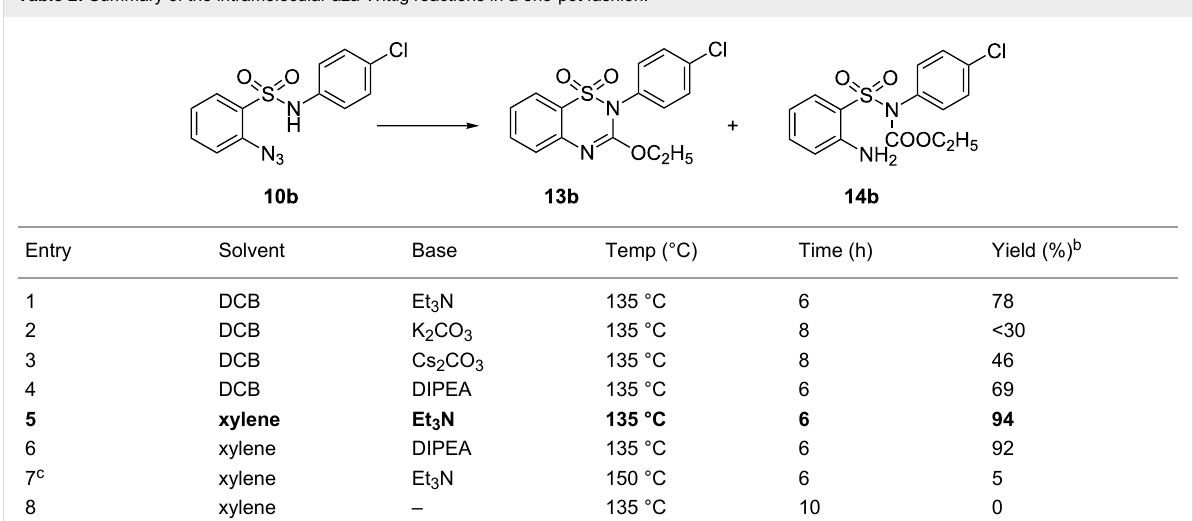
Table 2: Summary of the intramolecular aza-Wittig reactions in a one-pot fashion. a